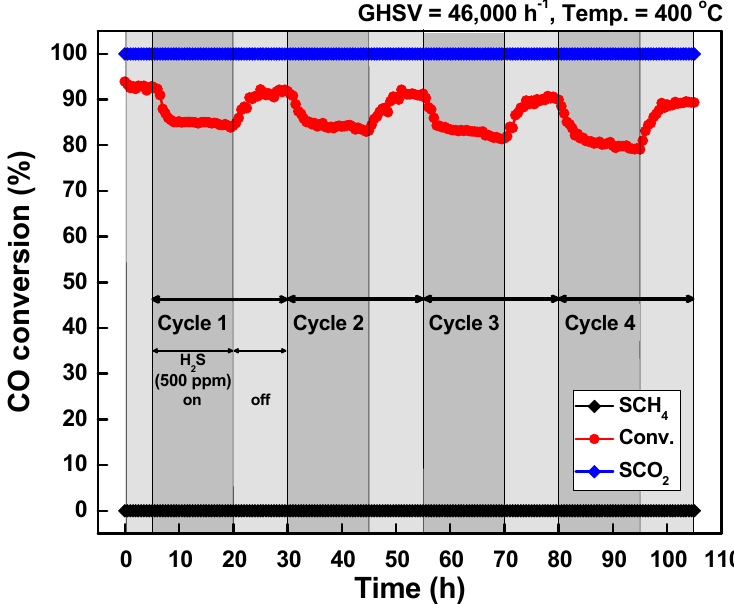
Figure 7. Sulfur-injection shutdown/restart cycle tests over PtCe-I Figure 7. Sulfur ‐ injection shutdown/restart cycle tests over PtCe ‐ I catalyst.